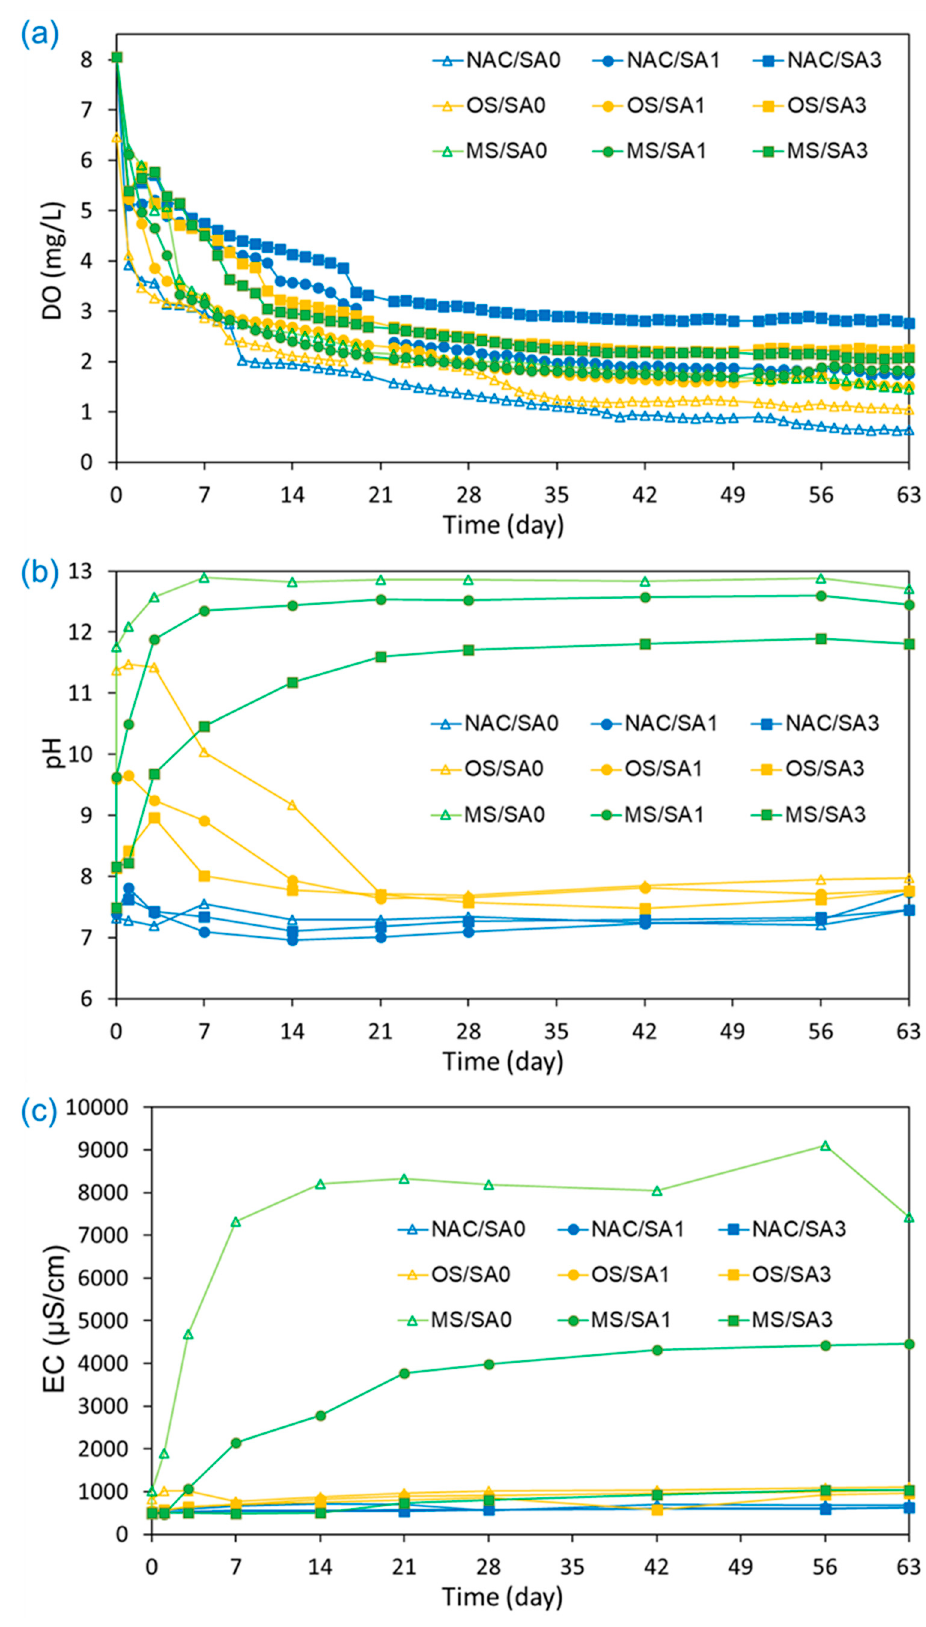
Figure 2. Effects of capping material on ( a ) dissolved oxygen (DO) concentration, ( b ) pH, and ( c ) electrical conductivity (EC) in the overlying water under different capping conditions during the 63-day incubation period.